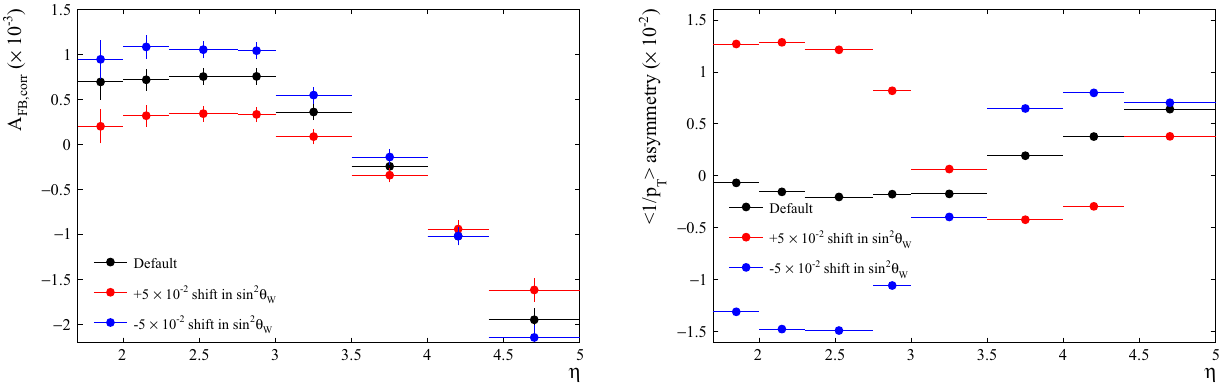
Fig. 4 The pseudomass (left) asymmetry and muon 1/ p T (right) asymmetry in bins of the muon pseudorapidity. The asymmetries are shown for three different values of sin 2 θ eff , including two extreme variations (red and blue) around the nominal value (black) lept